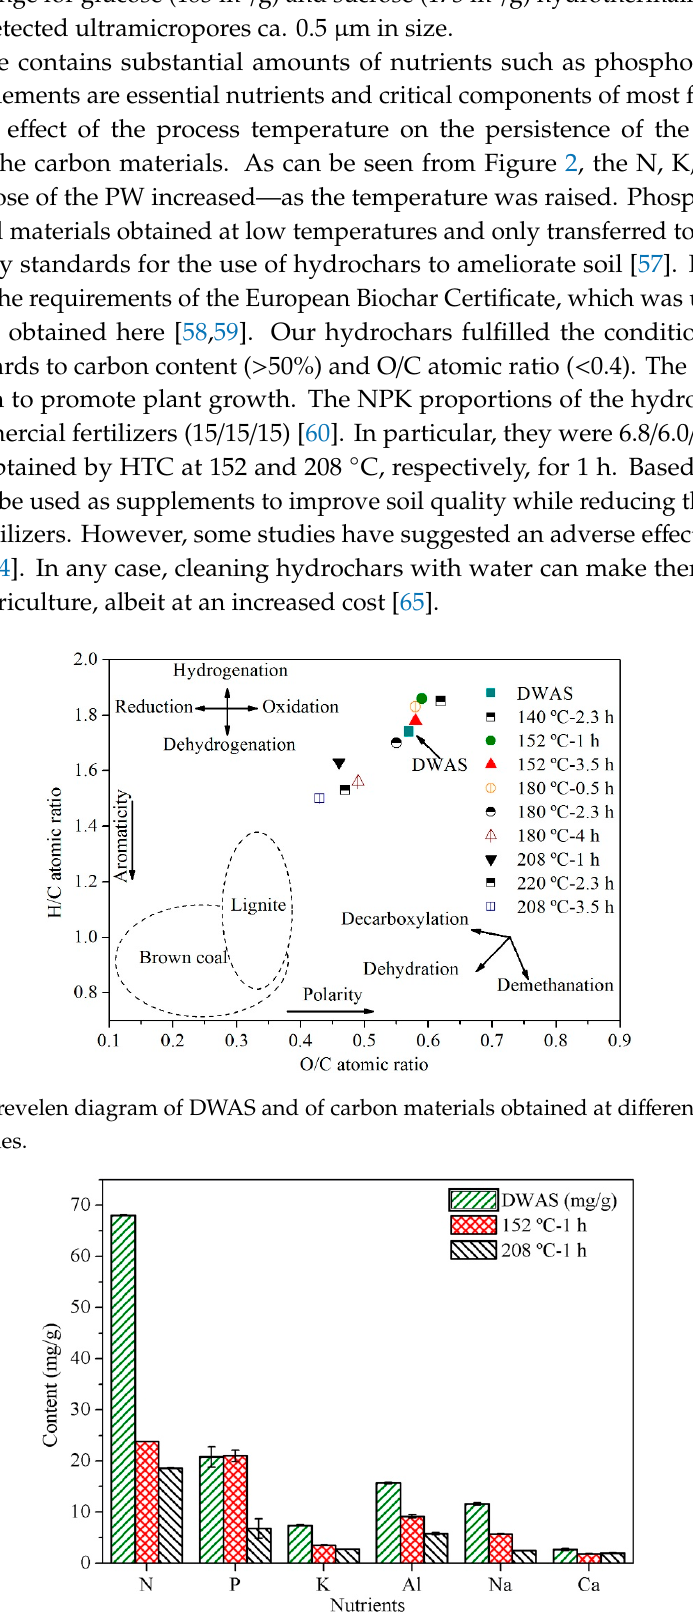
Table 4. Energy-related properties of the hydrochars.